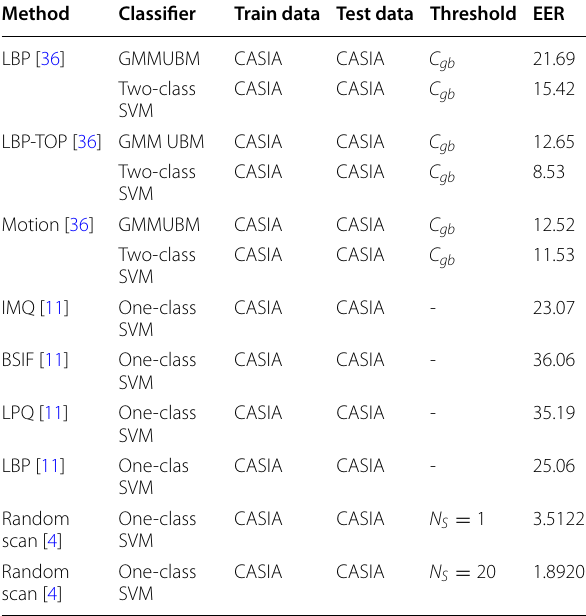
Table 5 State of the art methods which assume a client/subject independent frame and the corresponding error rates